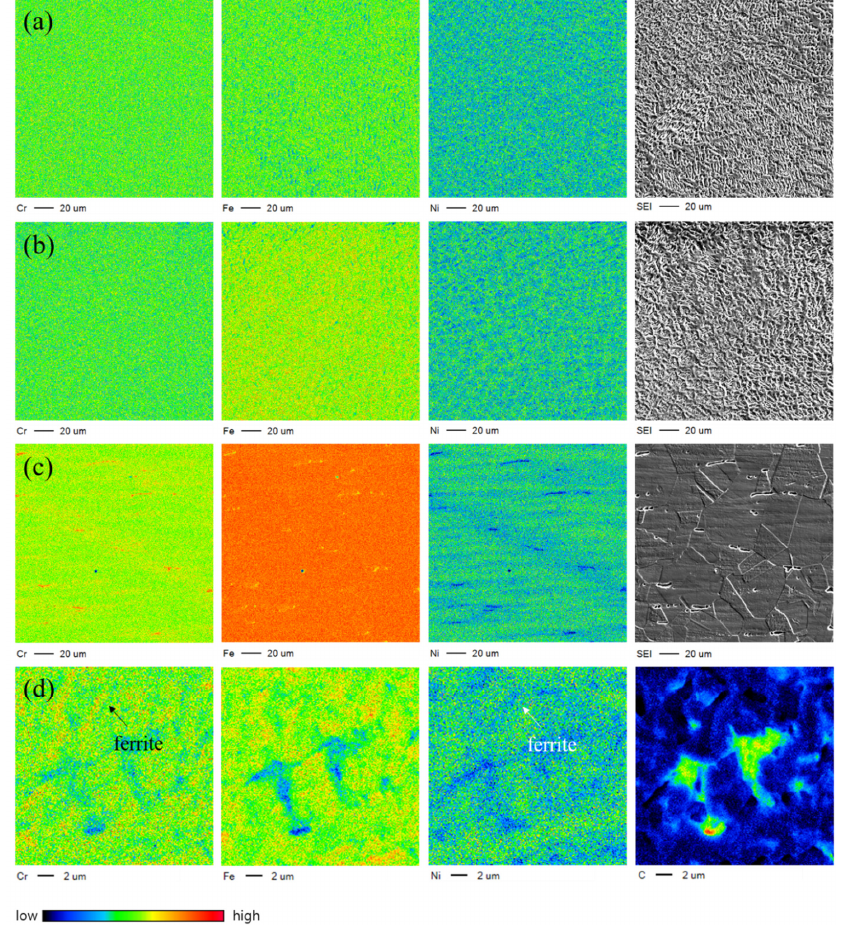
Figure 9. Elemental distributions (Cr, Fe, and Ni, at far left, center left, and center right, respectively) and scanning electron microscopic image (far right) obtained via electron probe microanalysis for specimens prepared by ( a ) underwater laser welding, ( b ) in-air laser welding, and ( c ) for the base metal; ( d ) expanded views of ( a ) highlighting an area of Cr